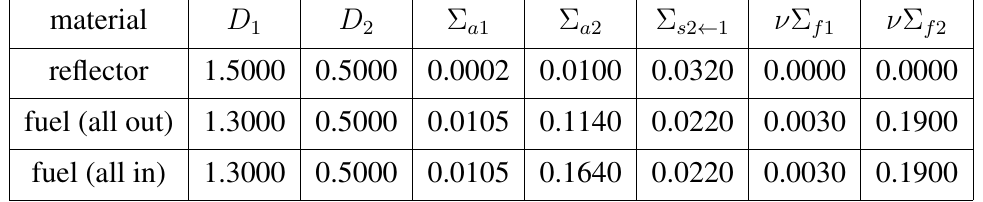
Table 1: Two-group diffusion constants